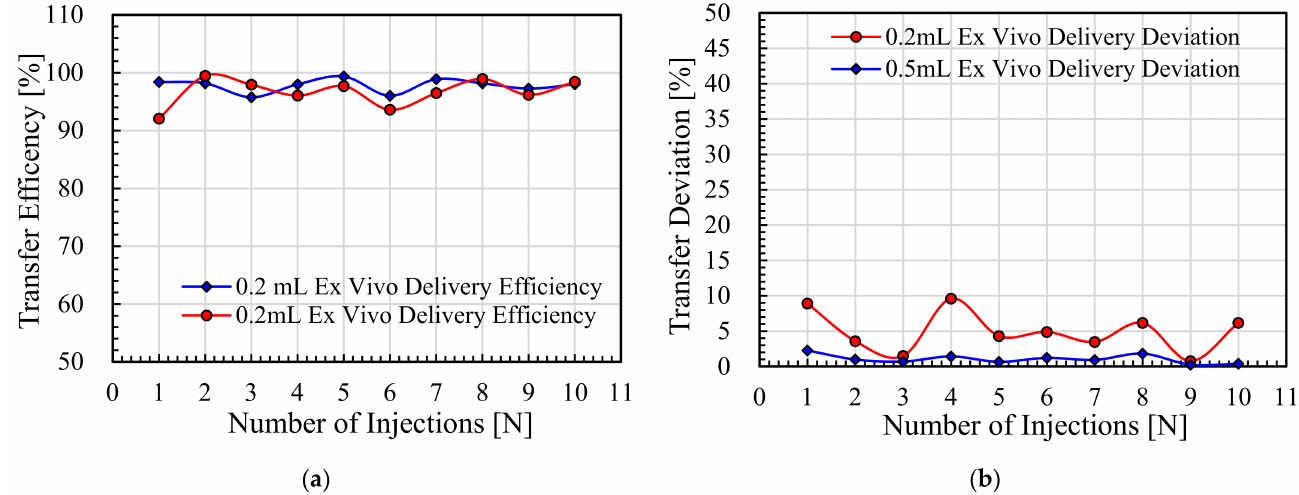
Figure 16. Ex vivo experimental results for Merial 206 vaccine delivery by the NFJIS into a porcine tissue specimen. ( a ) Pharmaceutic volume delivery efficiency at 0.2 mL/shot and 0.5 mL/shot, and ( b ) vaccine delivery deviation by NFJIS for variable-volume